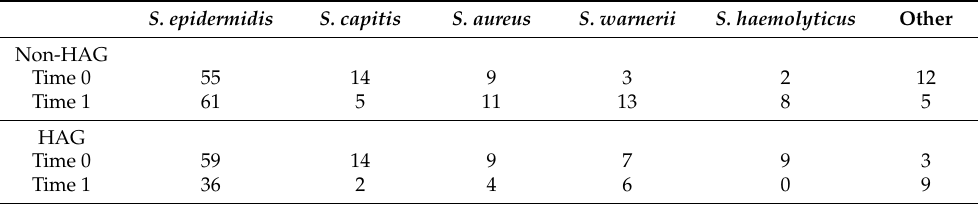
Table 1. Most frequently isolated microorganisms on MSA plates at different stages of the study.